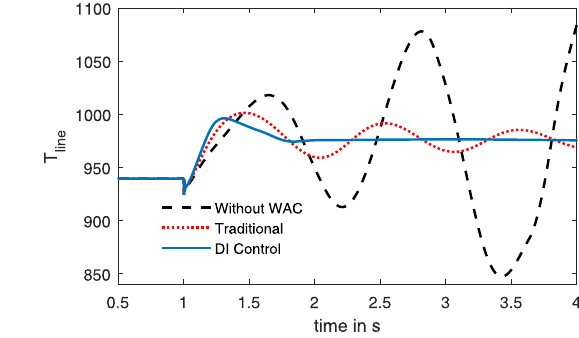
Fig. 11 Tie-line power deviations for load